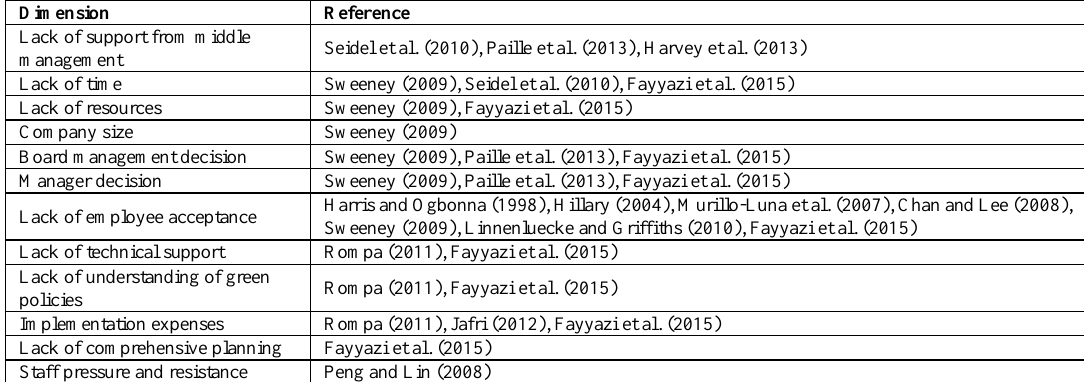
Table 8. Barriers to SHRM